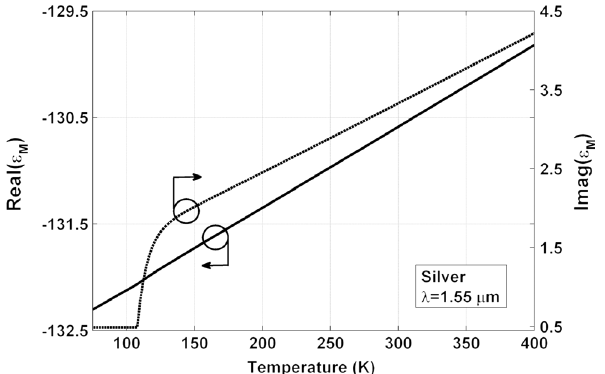
Figure 2 Real and imaginary parts of the permittivity of silver as a function of temperature at λ = 1.55 μ m. (Reprinted from